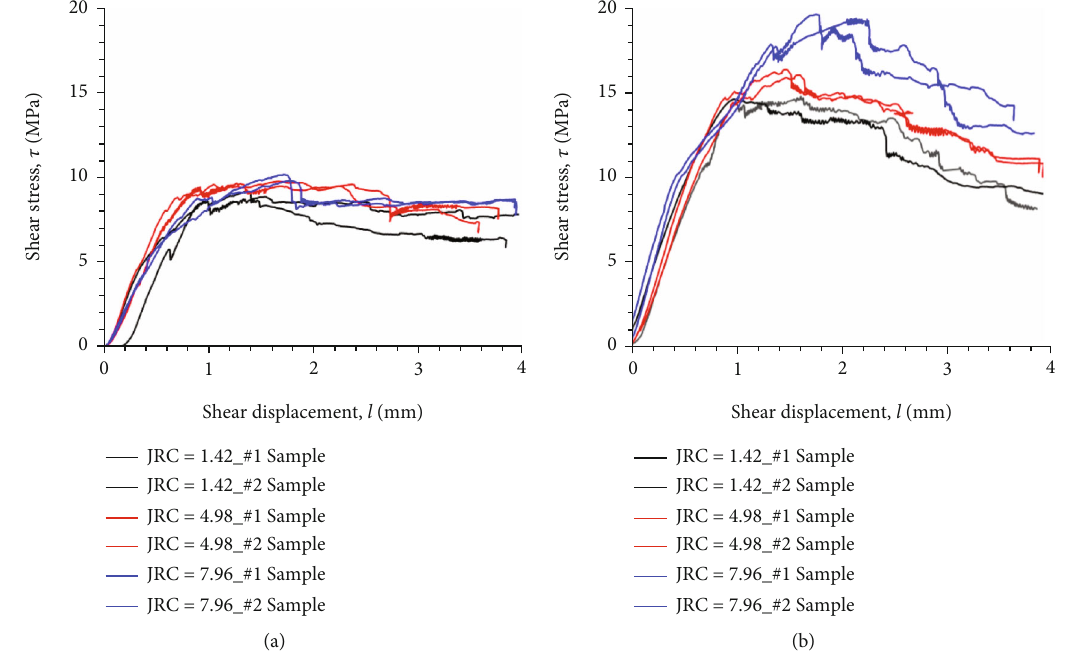
Figure 6: Shear stress-displacement curves of test joint specimens at two normal stresses: (a) 15MPa; (b) 30MPa.